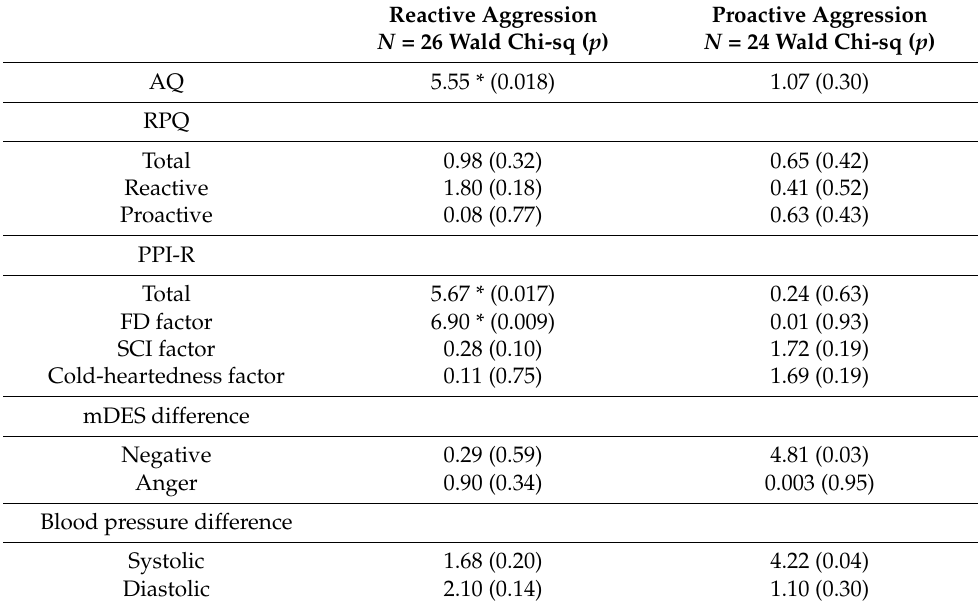
Table 6. Study 2: Negative binomial regression analyses outcomes on the relationship between study variables and continuous degree of reactive/proactive aggression displayed in VR. Reactive Aggression Proactive Aggression N = 26 Wald Chi-sq ( p ) N = 24 Wald Chi-sq ( p